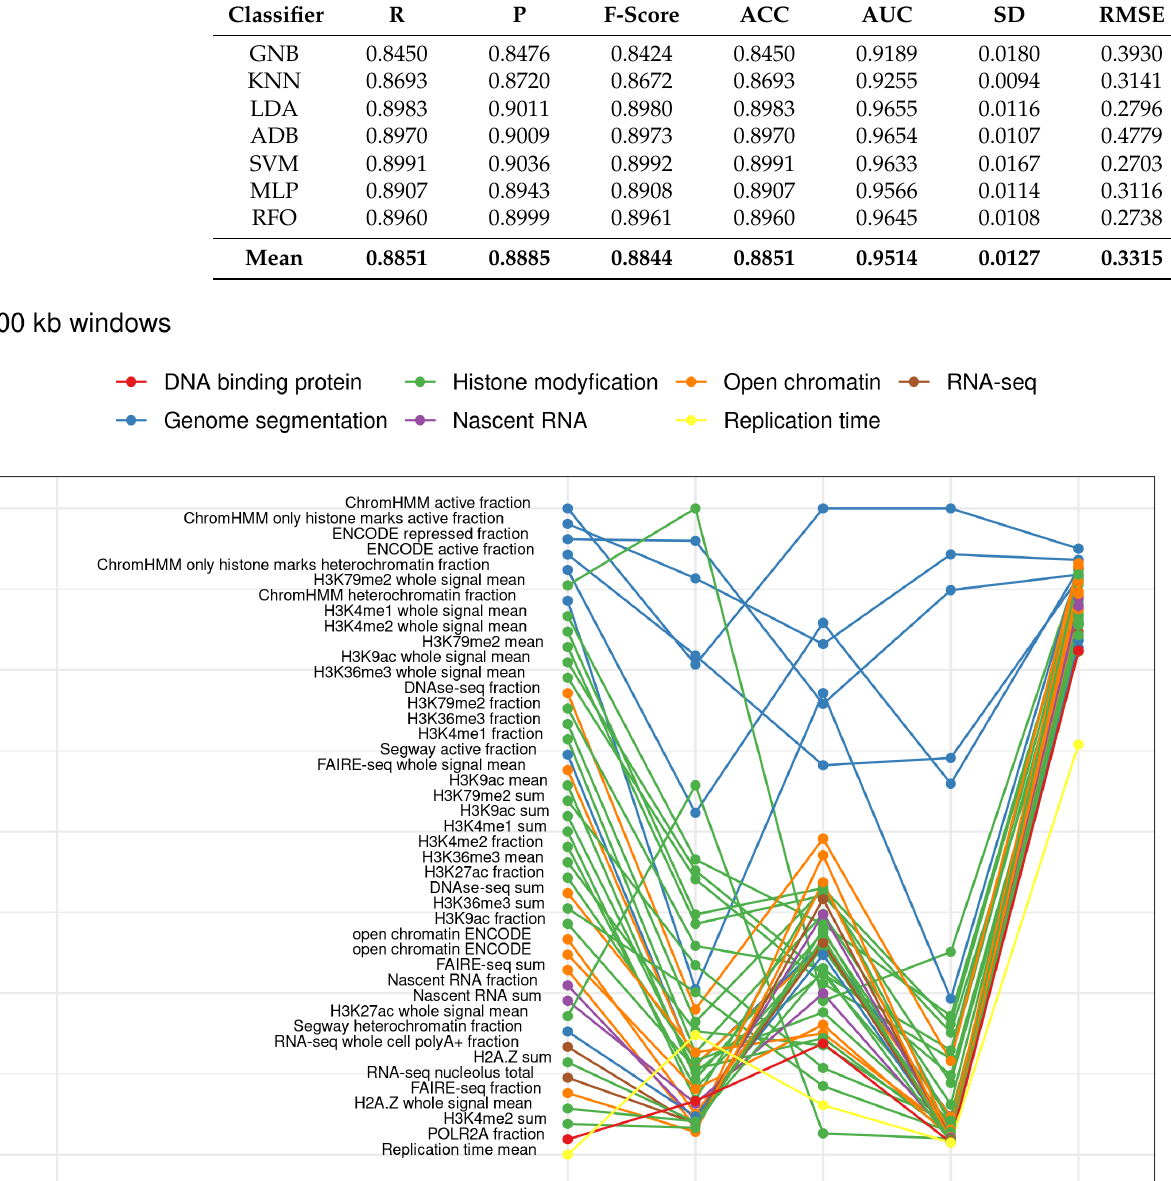
Table 5. Compartment prediction performance using various genomic marks of 100 kb genomic windows for various classifiers (all 428 genomic marks are considered for classification).